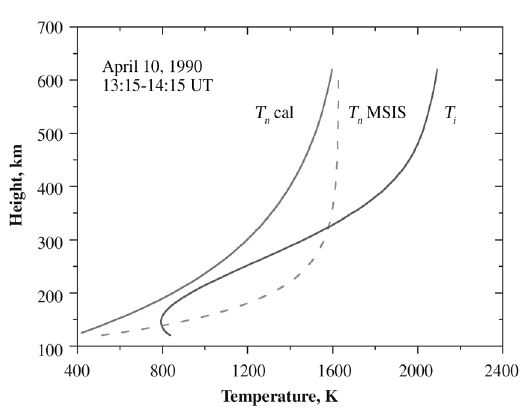
Fig. 4.9. Calculated and MSIS T n ( h ) profiles together with the observed at EISCAT T i ( h ) profile for the dis- turbed day April 10, 1990. Note that MSIS temperatures below 300 km are larger than T i – the situation is un- real for the conditions in